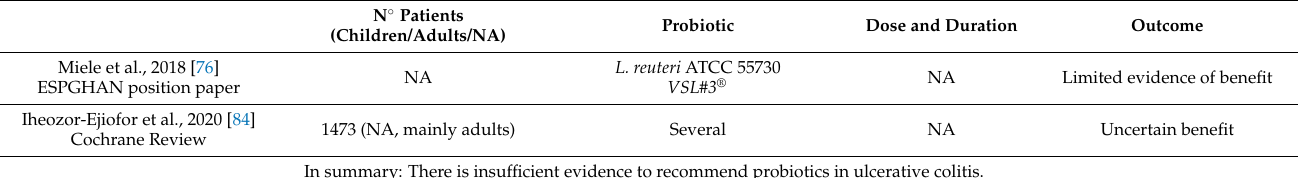
Table 10. Meta-analyses and systematic reviews on probiotics in ulcerative colitis. N ◦ Patients (Children/Adults/NA) Probiotic Dose and Duration Outcome NA Limited evidence of benefit Several NA Uncertain